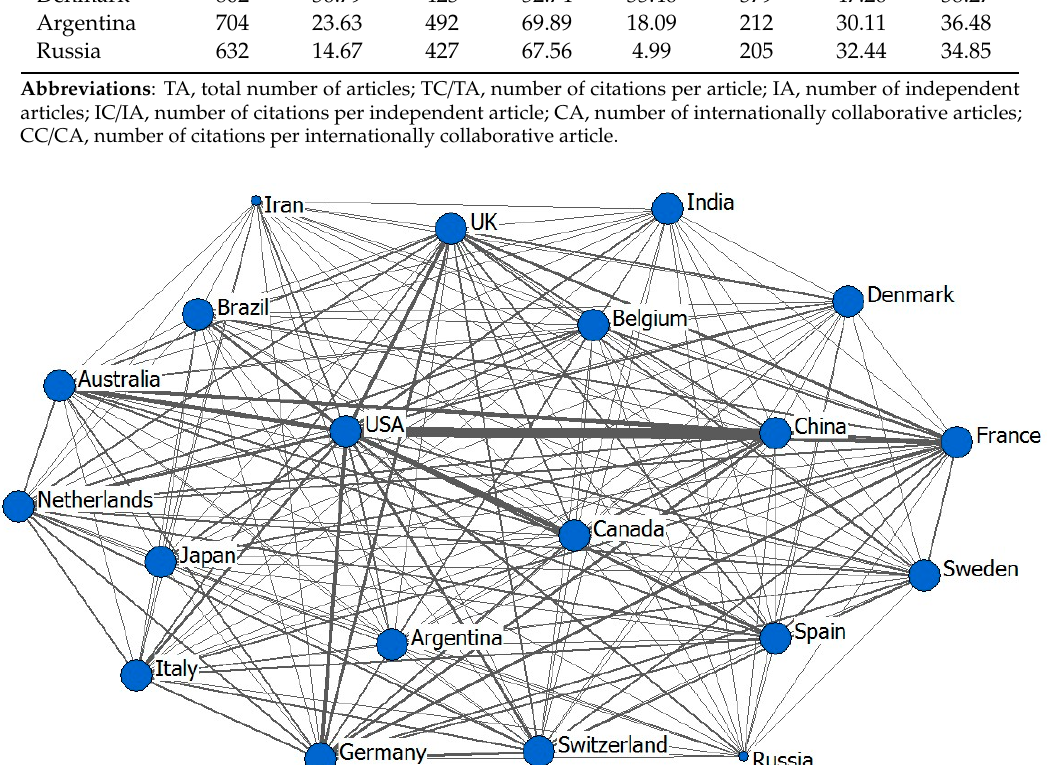
Figure 5. Global geographic distribution of authors in the field of SW research. 3.4. The Hot Topics in SW Research Keywords are natural language words that can reflect the core contents of papers. Therefore, a collection of keywords in an academic field can reveal the future trends of academic research in the specified field [16]. Before the 1990s, the article number was small, and its keywords information was incomplete. As a result, the articles from 1990 to 2019 were used for the top 20 frequently used keywords analysis with 10-year intervals (Table 5). The temporal change of keywords occurrences indicated the evolution characteristics of SW research hotspots. From 1990 to 1999, the research on soil moisture mainly focused on topics closely related to agricultural production, such as “water